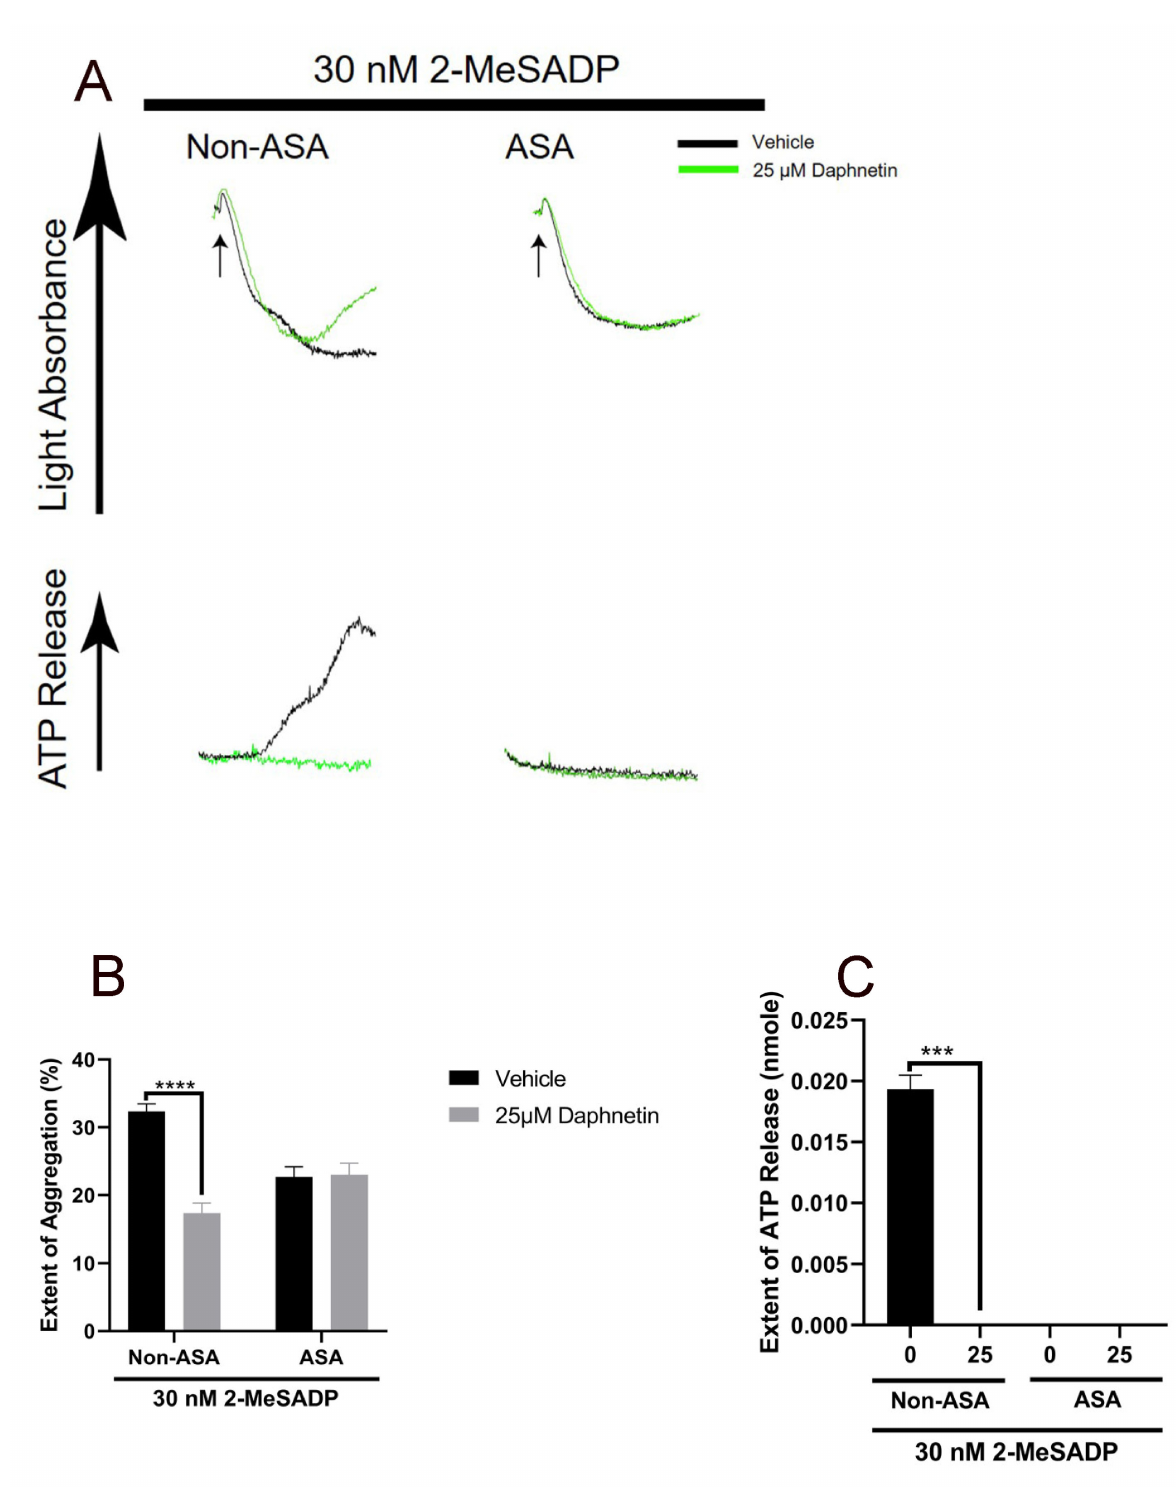
Figure 3. No additional effect of daphnetin on 2-MeSADP-induced platelet aggregation in aspirinated platelets. ( A ) Non-ASA- and ASA-treated murine platelets were stimulated with 30 nM 2-MeSADP in the presence of 25 µ M daphnetin. All tracings shown are representative of at least three different experiments ( n = 3). Quantification of the ( B ) extent of aggregation and ( C ) dense granule secretion from panel A. Data are presented as mean ± SE ***, p < 0.001; ****, p <